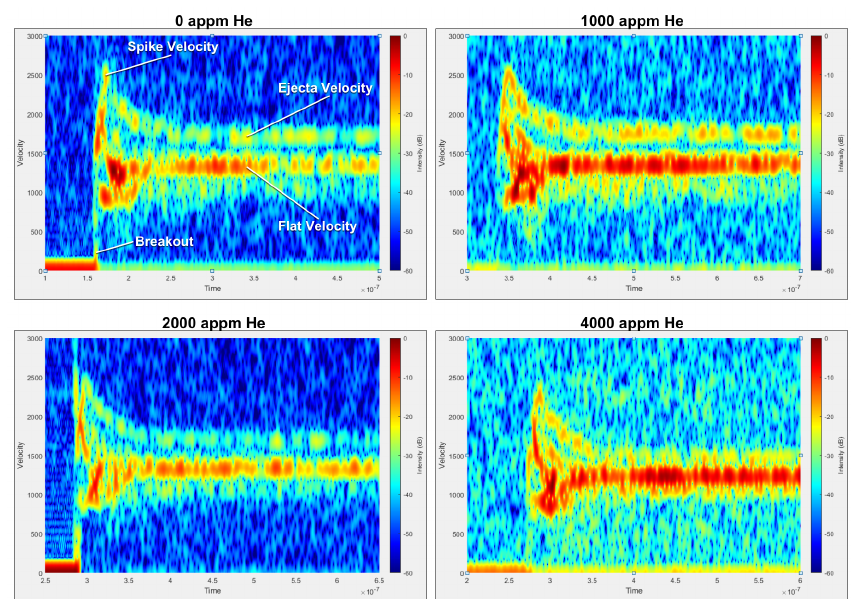
Figure 9. Spectrograms corresponding to copper with ( top-left ) 0 appm, ( top-right ) 1000 appm, ( bottom-left ) 2000 appm, and ( bottom-right ) 4000 appm helium.The spectrograms are colored by intensity, which varies between experiments depending on the signal to noise ratio for that particular